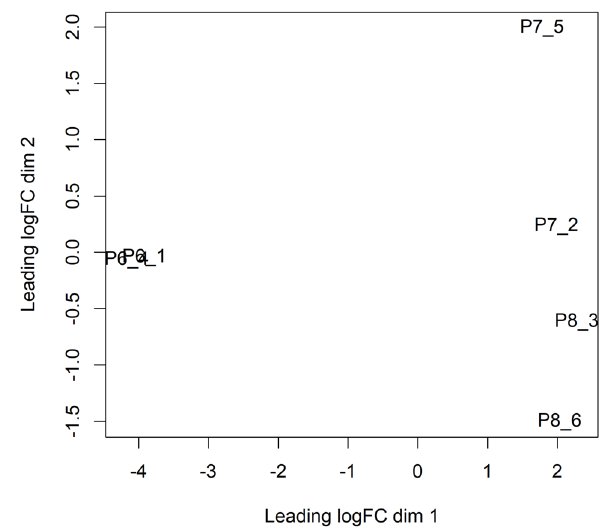
Figure 1. MDS plots showing overall differences in methylation levels between the samples. Replicate samples from the same population cluster together. The first dimension separates the luminal cells from the basal cells. The second dimension separates the Itga+ basal cells at the bottom from the Itga- basal cells at the